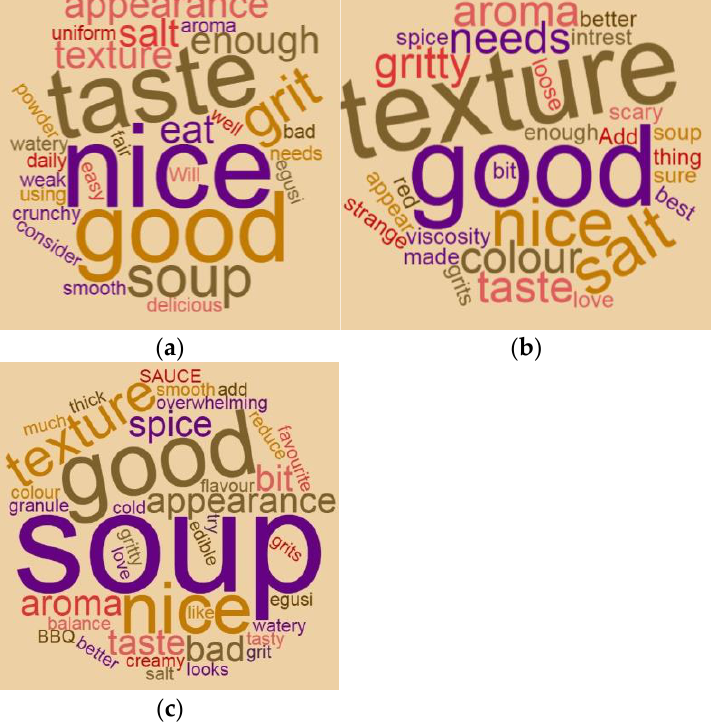
Figure 9. Sensory word cloud for instant egusi soup made with ( a ) boiled grit; ( b ) spherified grit ( c ) extruded